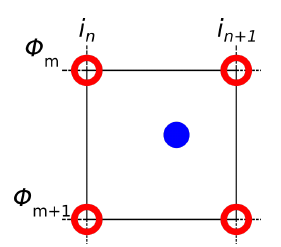
Figure A2. F θ ( Θ ) for two orbit